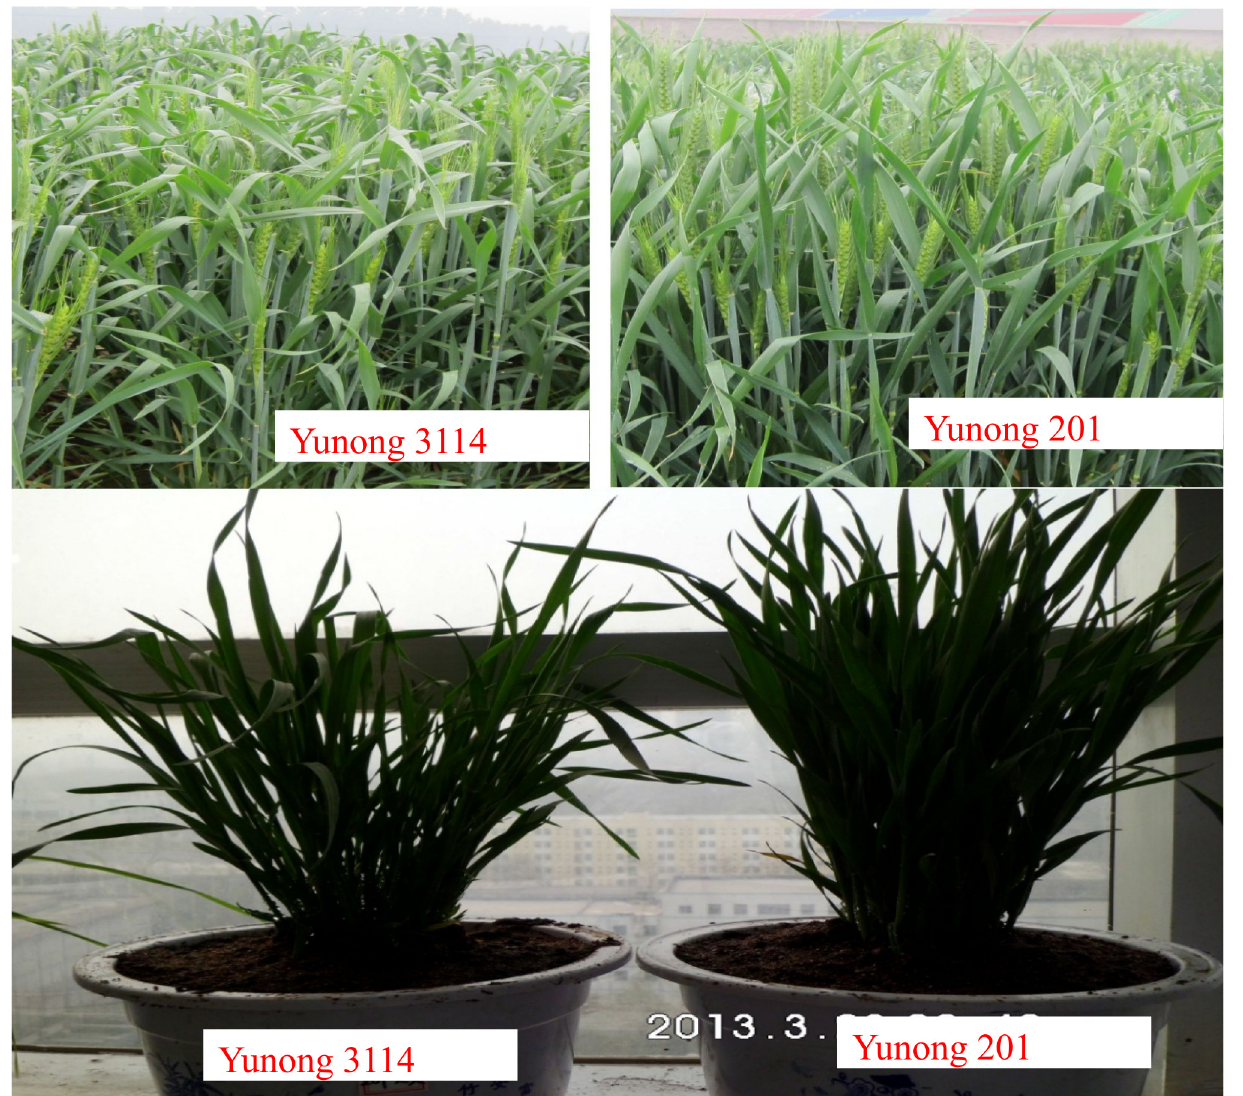
Fig 1. Comparison of plant architectures of Yunong 3114 and Yunong 201 in field and green